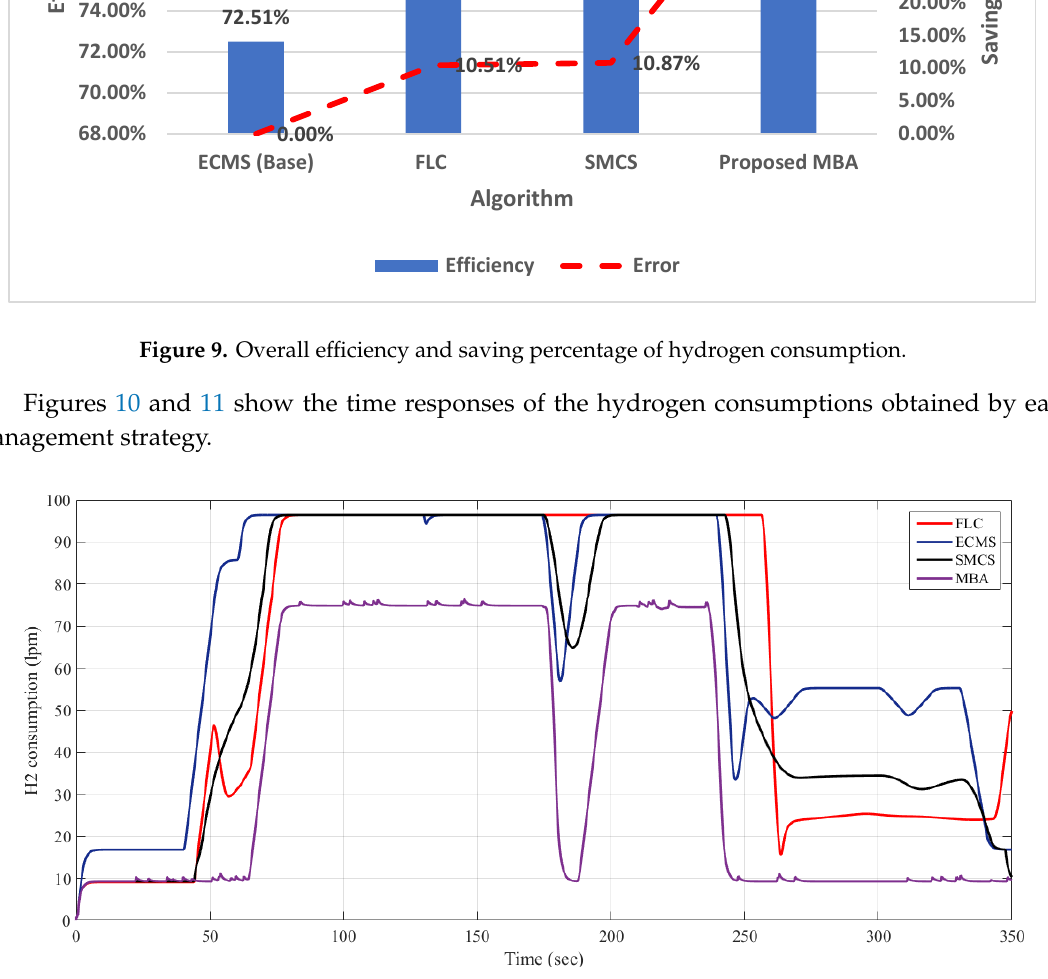
Figure 11. H 2 consumption variation in gm for different considered methods.